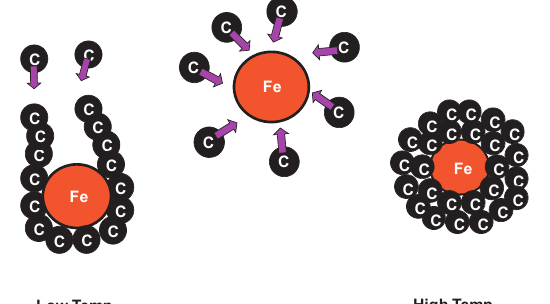
Fig. 2 Schematic of formation mechanism of carbon nanoparticles induced by Fe particles via pyrolysis method